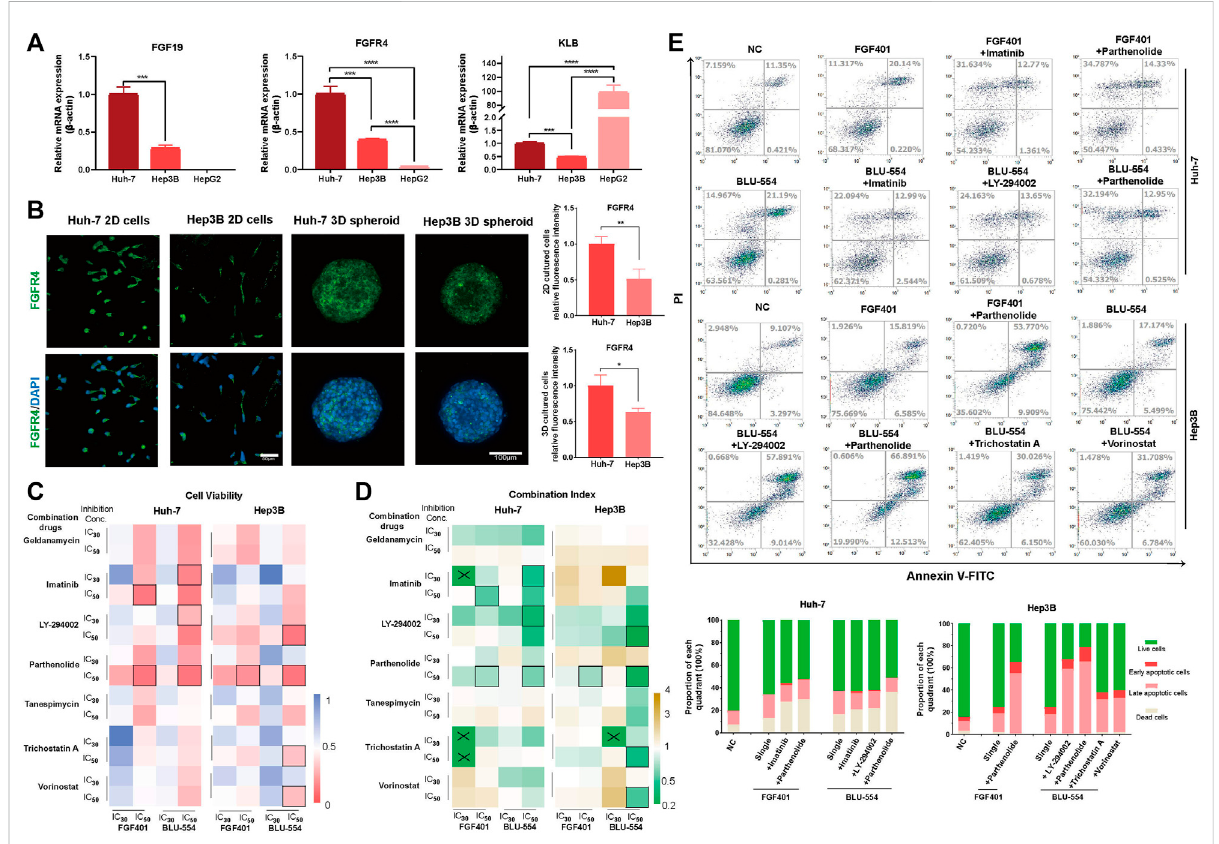
FIGURE 4 Evaluation of FGFR4 inhibitors combinations in HCC cells. (A) The expression of FGF19, FGFR4, and KLB in Huh-7, Hep3B and HepG2 cells was detected by qPCR. (B) IF staining to detect the FGFR4 protein level in Huh-7 and Hep3B cells. (C) Huh-7 and Hep3B cells were treated with two FGFR4 inhibitors (FGF401 and BLU-554) and seven candidate drugs. CCK-8 assay was used to quantify the cell activity. (D) The drug combination index is calculated according to the cell activity and drug concentration and is displayed in the heatmap. “ × ” indicates that the CI cannot be calculated, and “ □ ” indicates the selected combination drug schemes. (E) The fl ow cytometry apoptosis detection and statistical results of each quarter ineach of fi ve combinationdrug schemes and control groups in Huh-7 and Hep3Bcell lines. * p -value < 0.05, ** p -value < 0.01, *** p -value < 0.001, **** p -value <